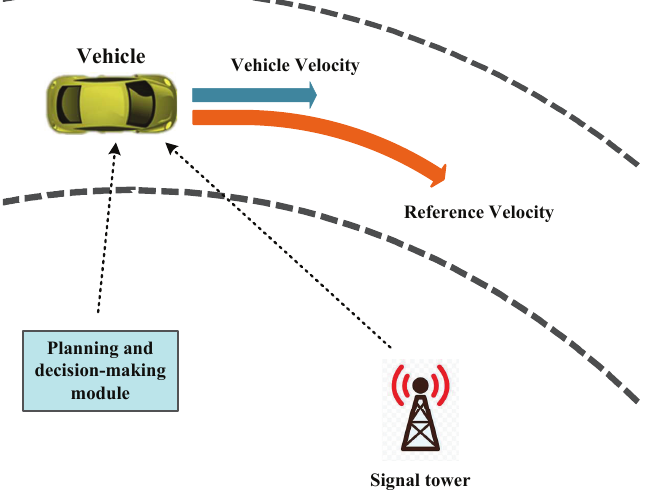
Figure 1. Schematic diagram of velocity tracking control.